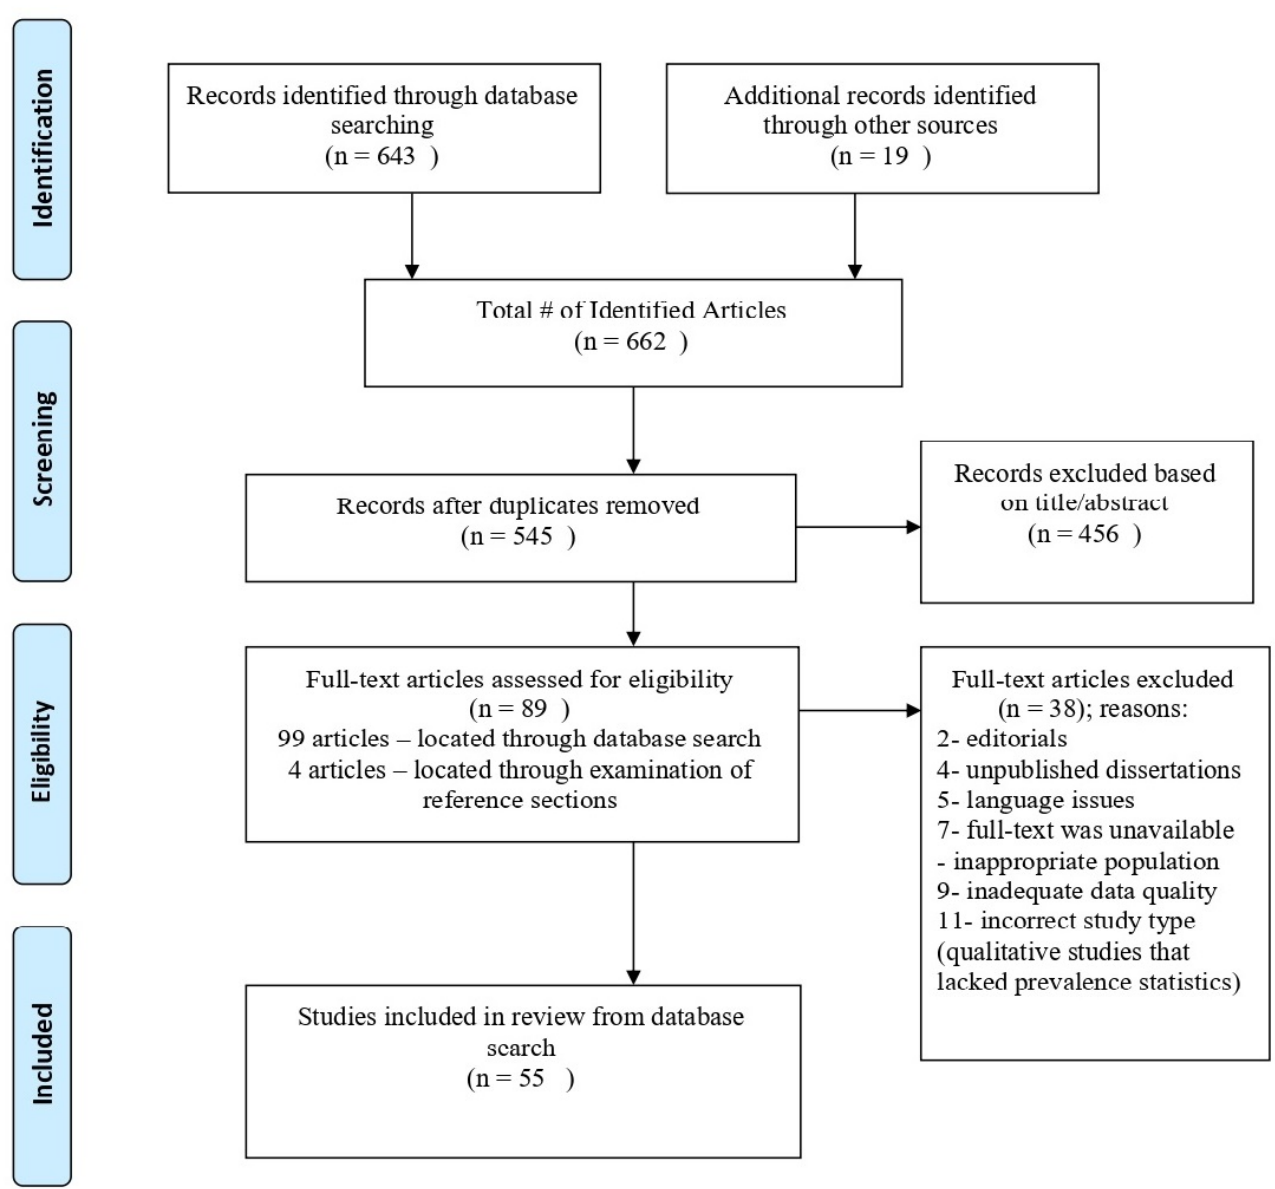
Figure 1. Diagram of study identification and selection process.